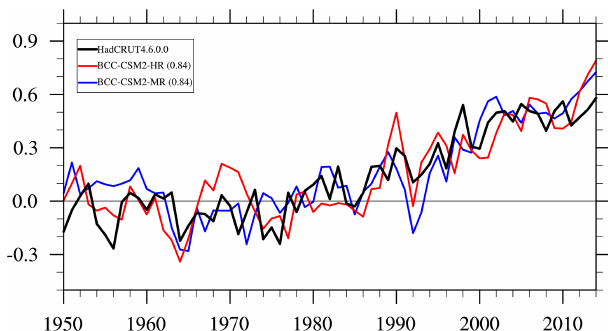
Figure 2. Time series of anomalies in the global mean surface air temperature from 1950 to 2014. The reference climate to deduce anomalies is for each individual curve from 1961 to 1990. The num- bers in the parentheses denote the correlation coefficient of 11-year smoothed simulations with HadCRUT4.6.0.0 (Morice et al., 2012)